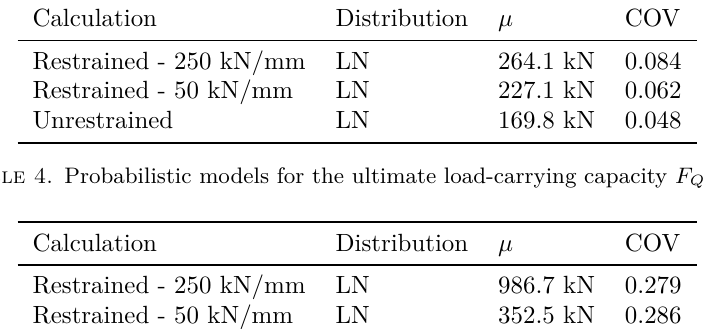
Table 5. Probabilistic models for the maximum horizontal restraint force F